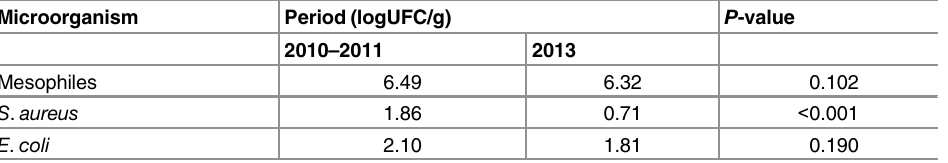
Table 2. Microorganism counts in ground beef from butcher shops in the evaluation (2010 – 2011) and verification (2013) periods. Microorganism Period